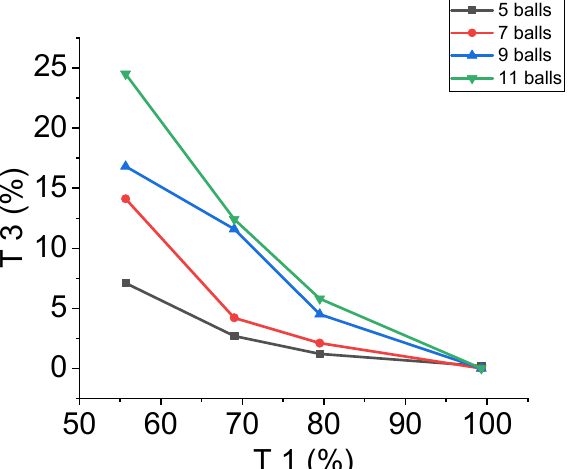
Figure 7. Mass fraction of middle size class (T2) against mass fraction of the feed material (T1) for different speeds.